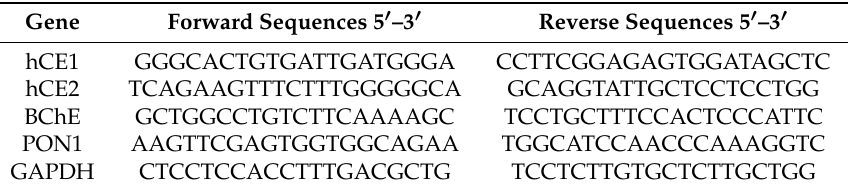
Table 3. Primer sequences for